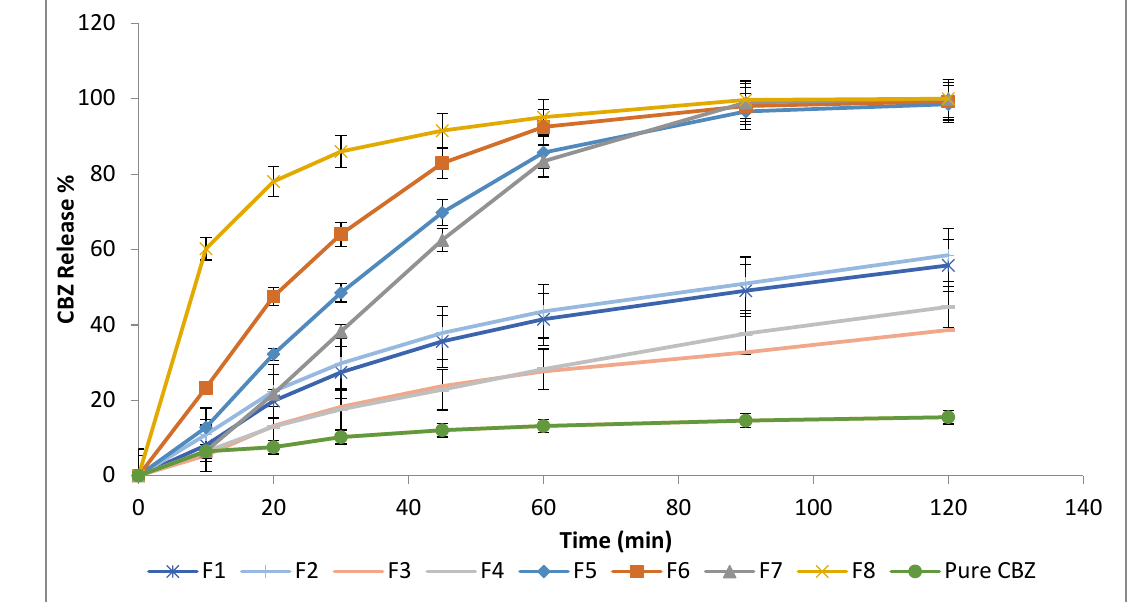
Figure 6. In vitro release profiles of pure CBZ and different formulations (F1 – F8) (15:85; CBZ: In vitro release profiles of pure CBZ and di ff erent formulations (F1–F8) (15:85; Soluplus ® ). CBZ: Soluplus ® ).